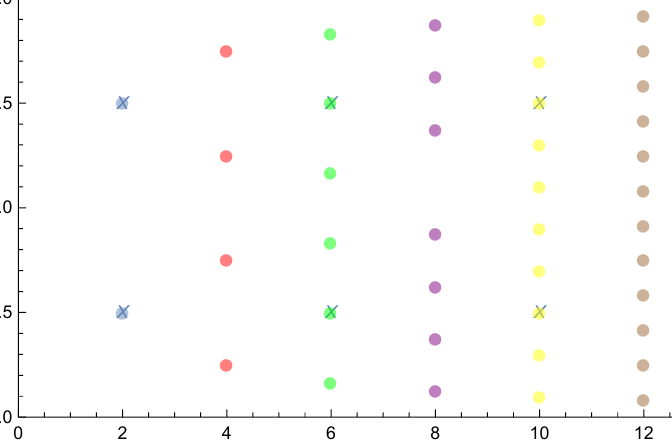
Figure 5 . A sample of the full spectrum in the s-channel for P abab (cid:0) P abba represented by the pairs ( r; s ) of the h r;s exponents ( r is on the y-axis, and s on the x-axis. The spectrum considered in [1], depicted as crosses, is seen to be a tiny subset of the full spectrum: the projections of the dots on the y-axis in fact should cover it densely (represented here are exponents for M = 2 ; 4 ; 6 ; 8 ; 10 ; 12 only). appears, despite the non-unitarity of the